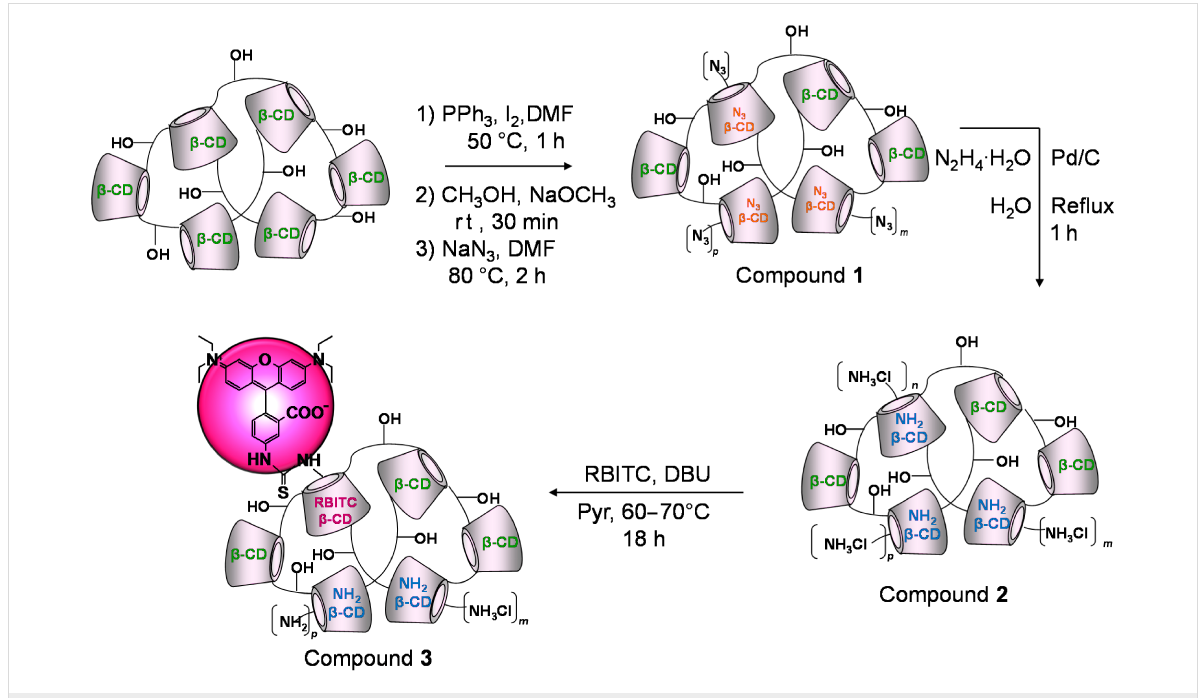
Scheme 2: Synthetic strategy for the rhodaminylation of β -CD polymer.